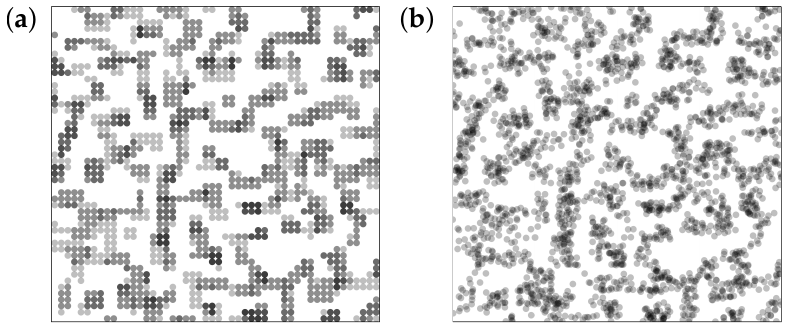
Figure 4. Mock TEM picture generation. ( a ) a slice, with a thickness of 5-particle diameters, is extracted from the simulation after a certain number of MC steps; ( b ) small random displacements, as described in the text, are applied to every particle in the slice. Darker spots are due to two or more particles superimposed along the line of sight. The polymer is polybutadiene rubber (BR, Lanxess Buna CB25, γ d p = 18.4 mJ/m 2 and γ p p = 3.7 mJ/m 2 ) and the filler precipitated silica (Ultrasil VN3, granulated form, γ d p = 18.7 mJ/m 2 and γ p p = 22.7 mJ/m 2 ). A filler volume content of φ = 20% and a temperature of T = 160 ◦ C were